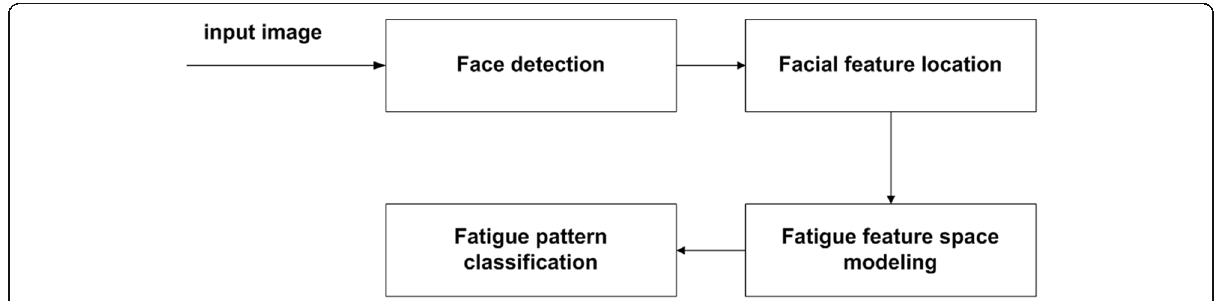
Fig. 4 Driving fatigue detection process based on machine